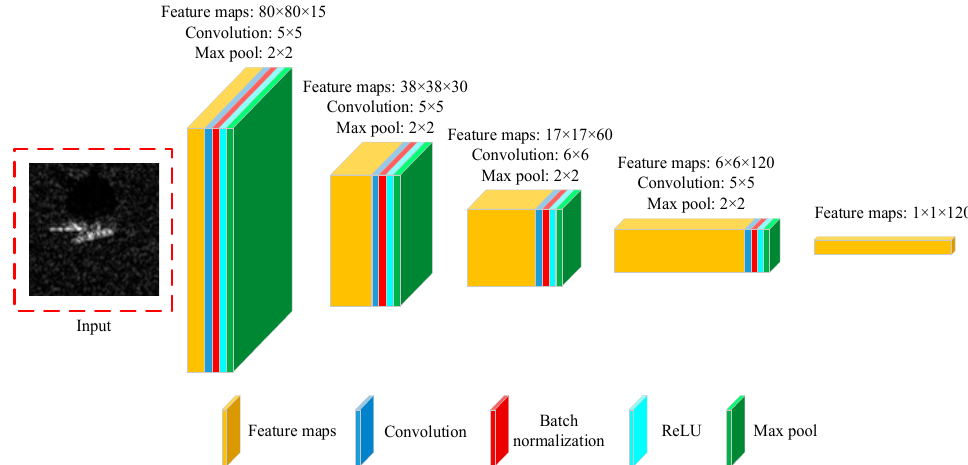
Figure 2. The details of one stream of the multi-stream CNN framework.2.2.1. Convolutional Operation.